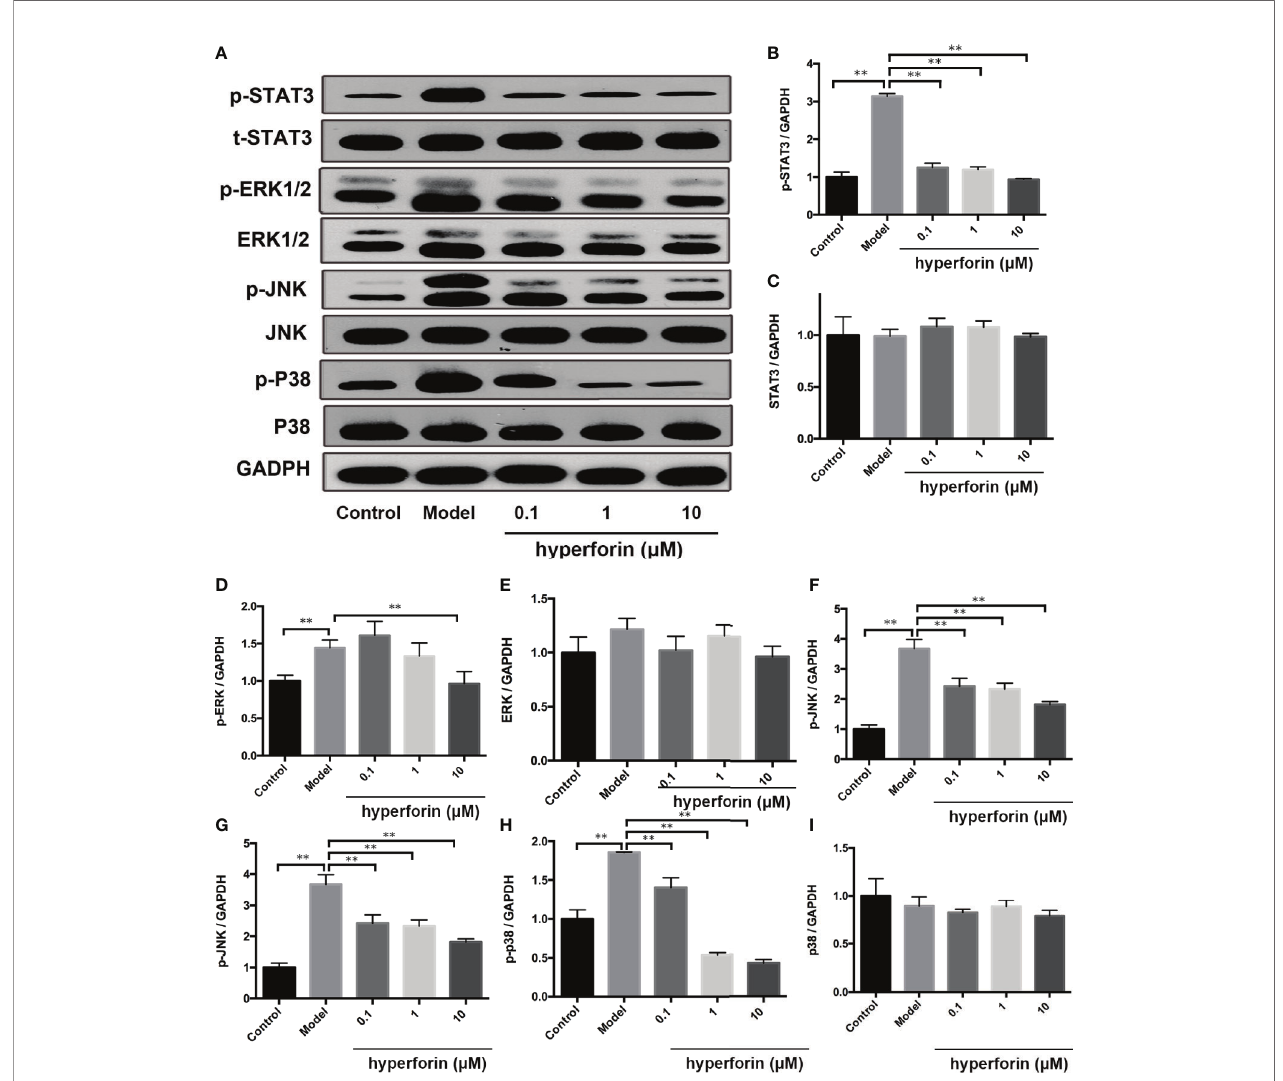
FIGURE 8 | Hyperforin inhibits phosphorylation of MAPK and STAT3 pathway components in in vitro cultured gd T cells. (A) Representative images of Western blot. (B – I) quanti fi cation of the Western blot data by densitometric analysis and normalization to GAPDH (n = 3 independent experiments). **P < 0.01 vs model